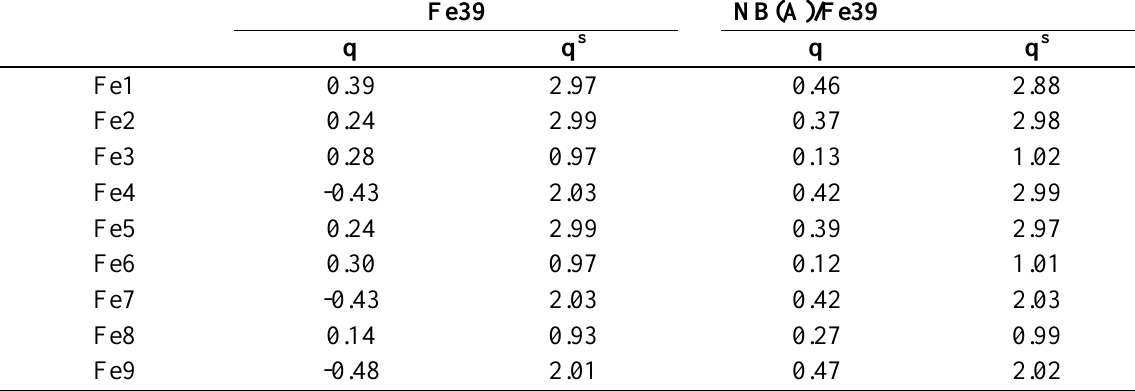
Table 2. Electron (q) and spin (q s ) densities on the ‘active’ centers of the ‘naked’ cluster and the cluster with NB adsorbed on